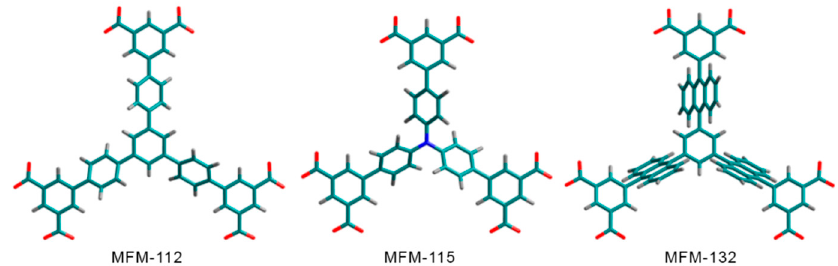
Figure 8. Structure of rotor linkers used in MFM-112, -115, and -132. Reproduced with permission from [12]. https://pubs.acs.org/doi/10.1021/jacs.7b05453; further permissions should be directed to the